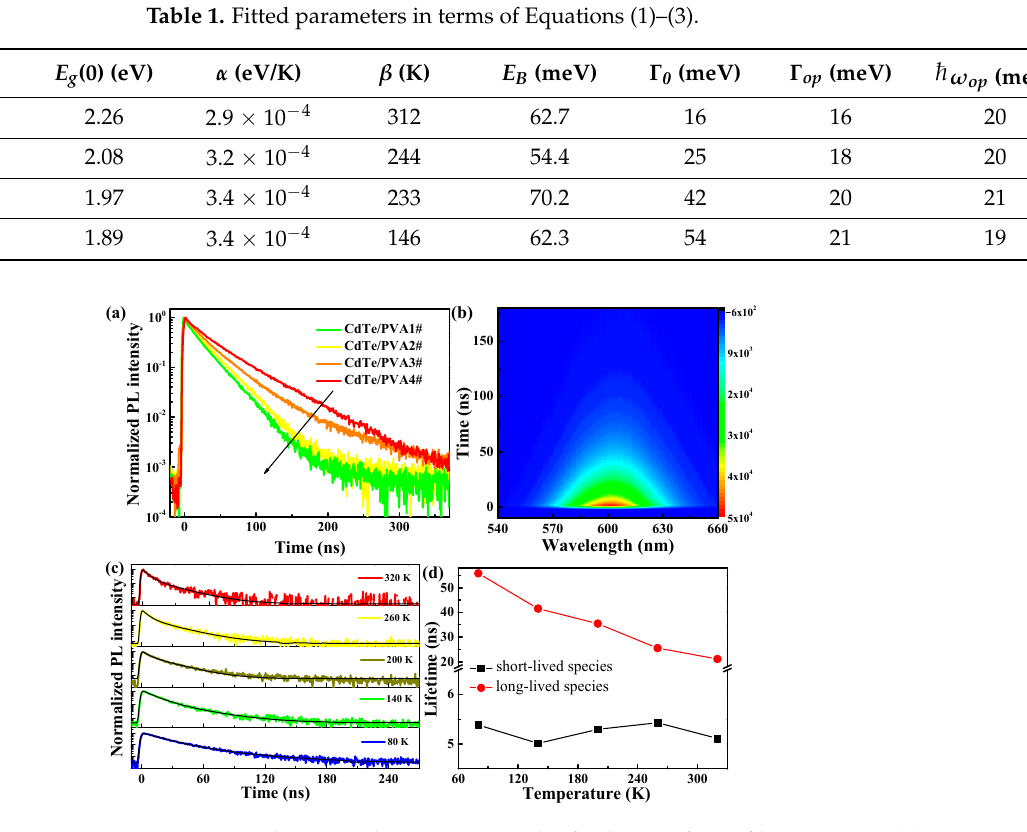
Figure 3. ( a ) PL decays at the emission peak of CdTe NC/PVA films at 290 K. ( b ) Time-resolved PL contour spectra from -10 to 200 ns at 290 K. ( c ) PL decays of CdTe NC/PVA 3# film at different temperatures; the black line is the fitting curve. ( d ) The lifetimes of PL for CdTe NC/PVA 3# film from a double exponential fitting with the temperature change.